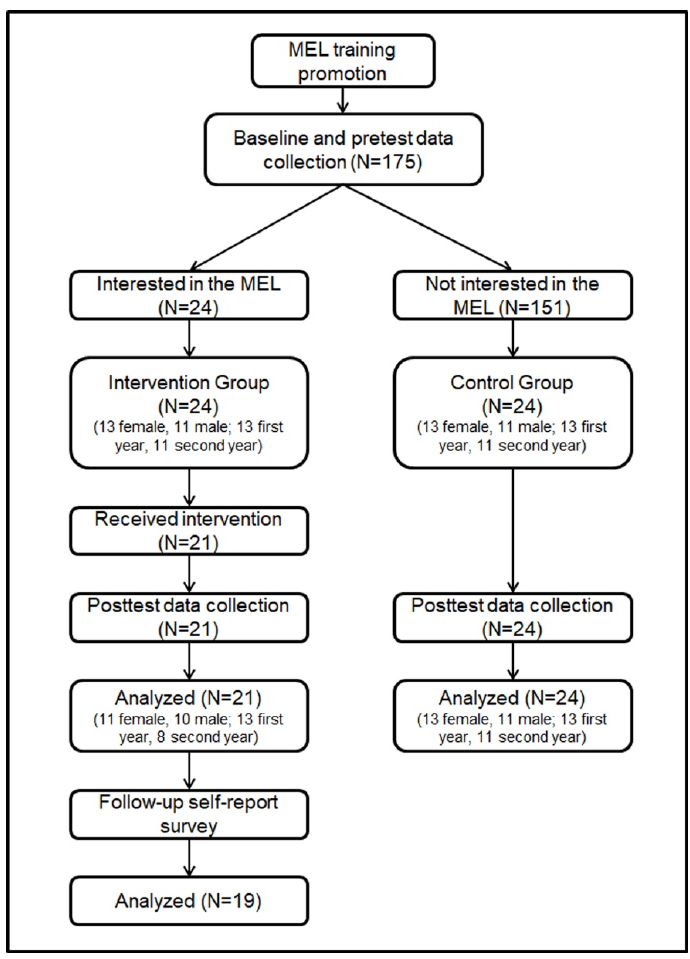
Figure 1. Flow of the study with a pre/post controller design and a follow ‐ up self ‐ report survey.